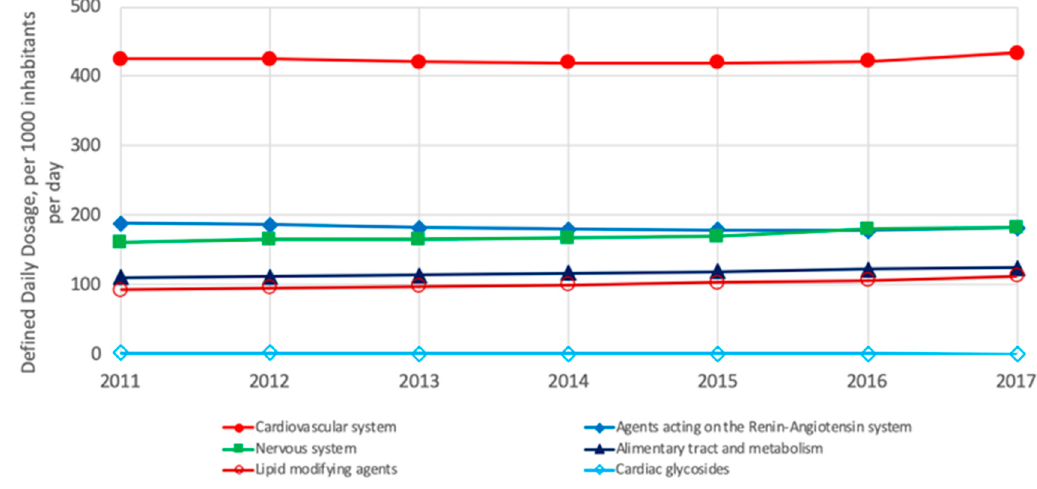
Figure 12. Most consumed pharmaceuticals in the US and Canada between 2011 and 2017 [3].